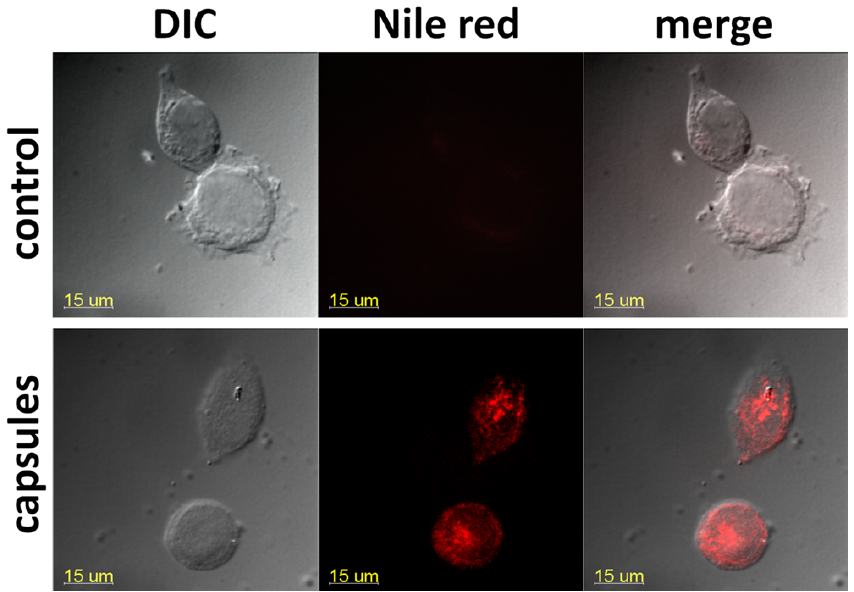
Figure 13. MCF7 cell fluorescence after 2 h incubation with the Nile Red-labeled capsules (bottom row). Untreated control—upper row. Bar—15 μ m.